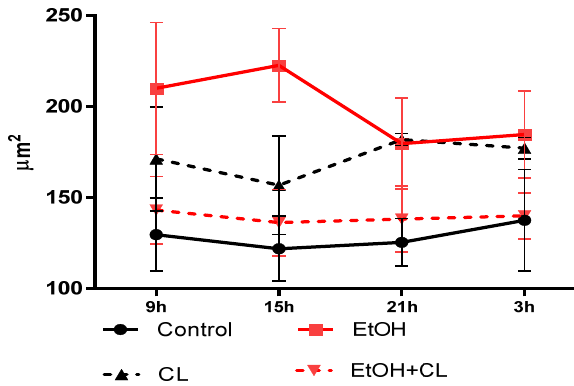
Figure 14. Daily dynamics of hepatocyte area of rats.